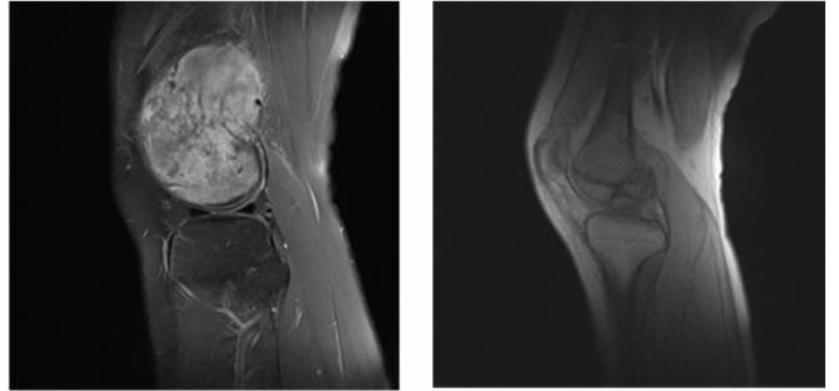
Figure 7. US ( the left ) and NS ( the right ) example images. After classifying the dataset, we proceeded with data enhancement processing. The effect of data enhancement processing is shown in Figure 8, where the left column is the original label, the middle column is the segmentation rendering without optimization processing, and the right column is the optimized segmentation renderings. We can see that there is an incomplete and inaccurate segmentation in the middle column, and after optimization, the segmentation can obtain a relatively complete and accurate tumor region prediction. From here we can see that after the data optimization, the performance of the model has been significantly improved.